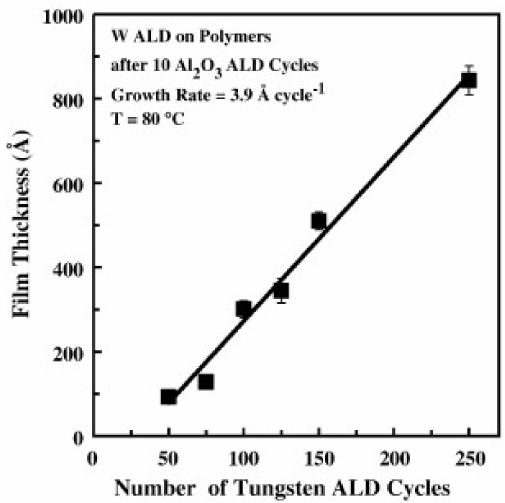
Figure 13. Profilometry measurements of W ALD film thickness on different polymers vs. the number of W ALD cycles. Al 2 O 3 ALD was used as a seed layer (10 ALD cycles) (reprinted from [64], Copyright (2008), with permission from Elsevier).